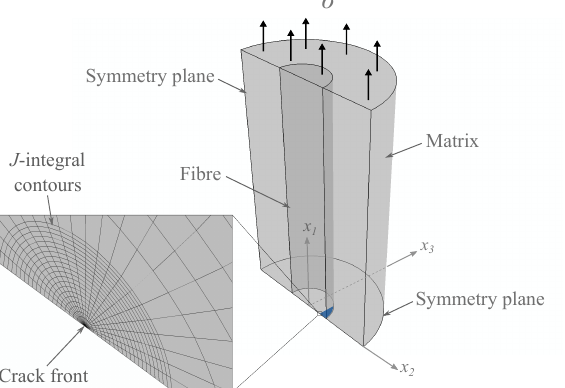
Figure 2. FE model with details of the boundary conditions and finite-element meshing of the crack tip region.